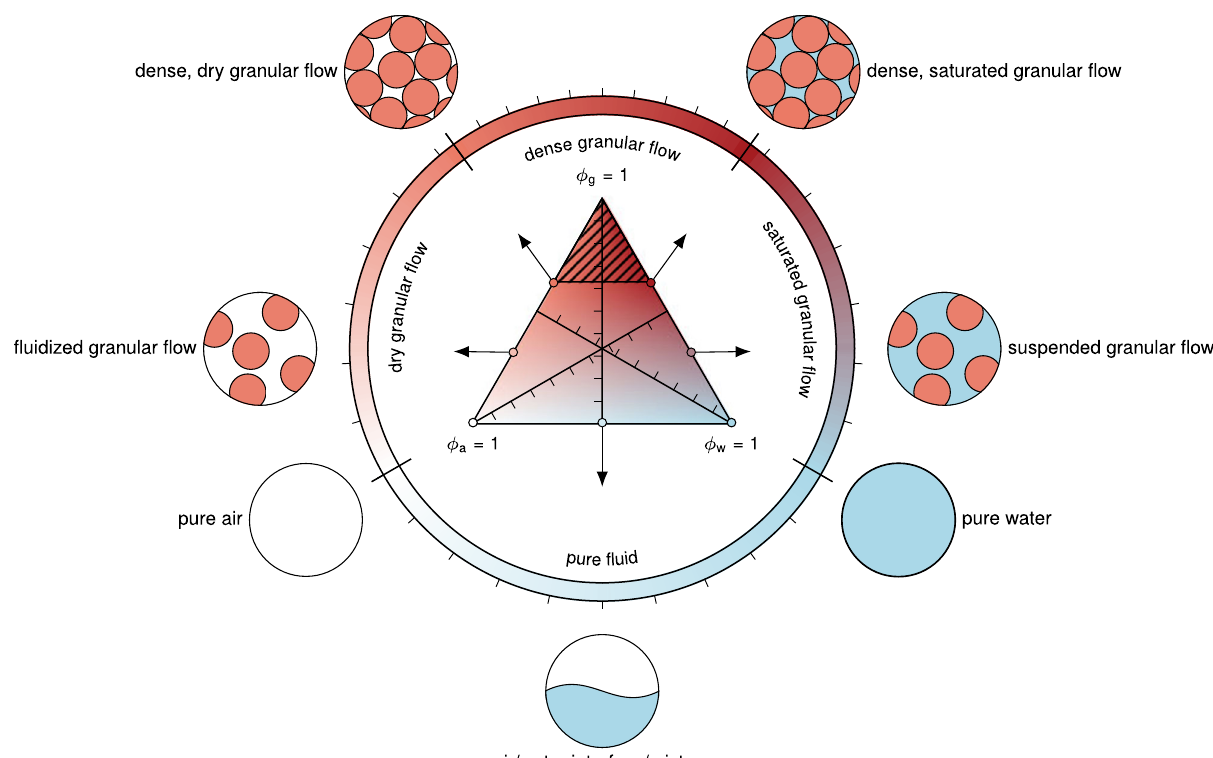
Fig. 2 Phases and the corresponding fl ow regimes. The multiphase Navier – Stokes equations allow the representation of various fl uids and fl ow regimes by combining the phase fractions as shown in the diagram. Phases differ in densities and stress models and can thus represent the behaviour of the various fl ow regimes. The striped area is excluded, accounting for the pore space that is always present in granular material. The coloured ring represents a reduced colour map of limiting cases. The relevant part of this ring is used as colour map in this paper to visualise the local phase fractions. Table 1 Model parameters for the small-scale experiment of Viroulet et al. 23 and the Lake Askja case 6 .